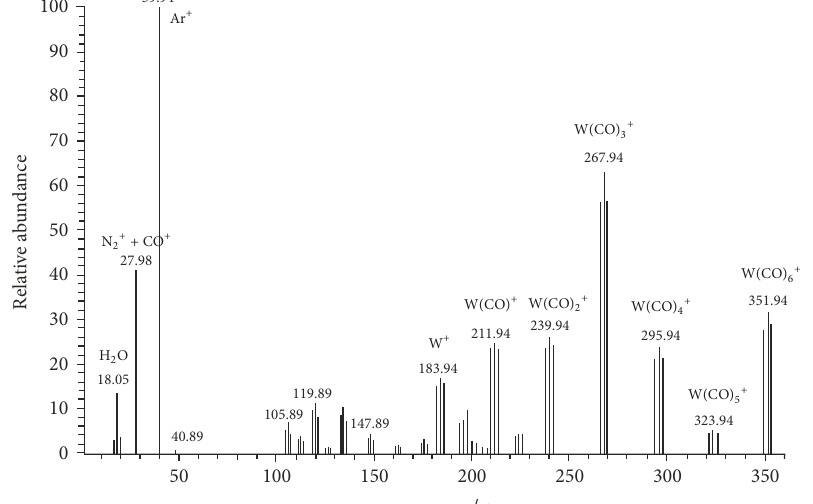
Figure 2: : Mass spectrum of gas in the experimental chamber when the crucible with W(CO) 6 is